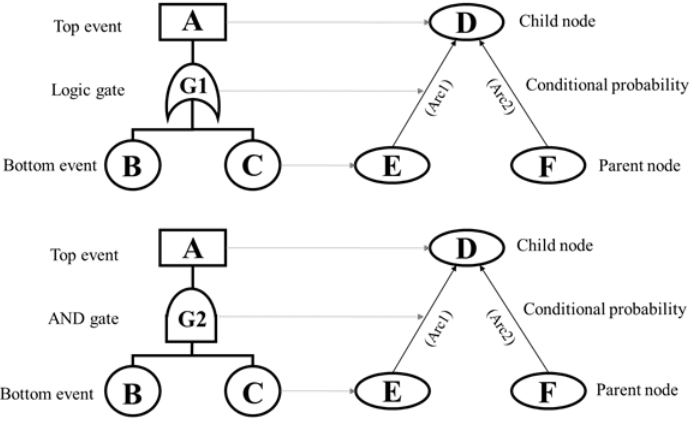
Figure 3. Mapping the FT to BN.